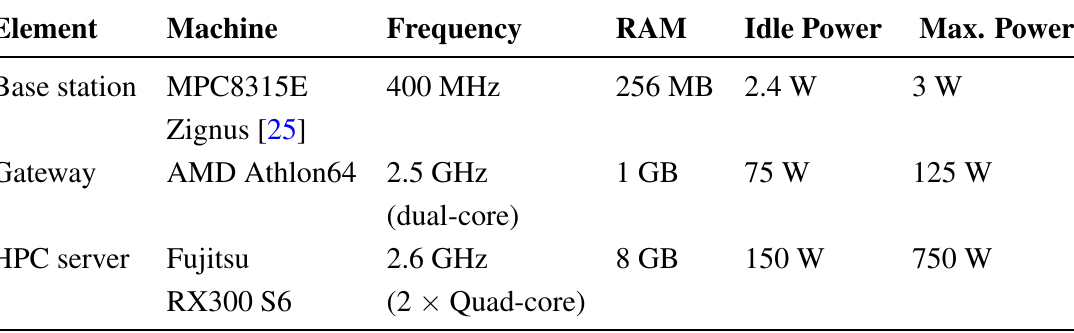
Table 2. Parameters for simulated sensor